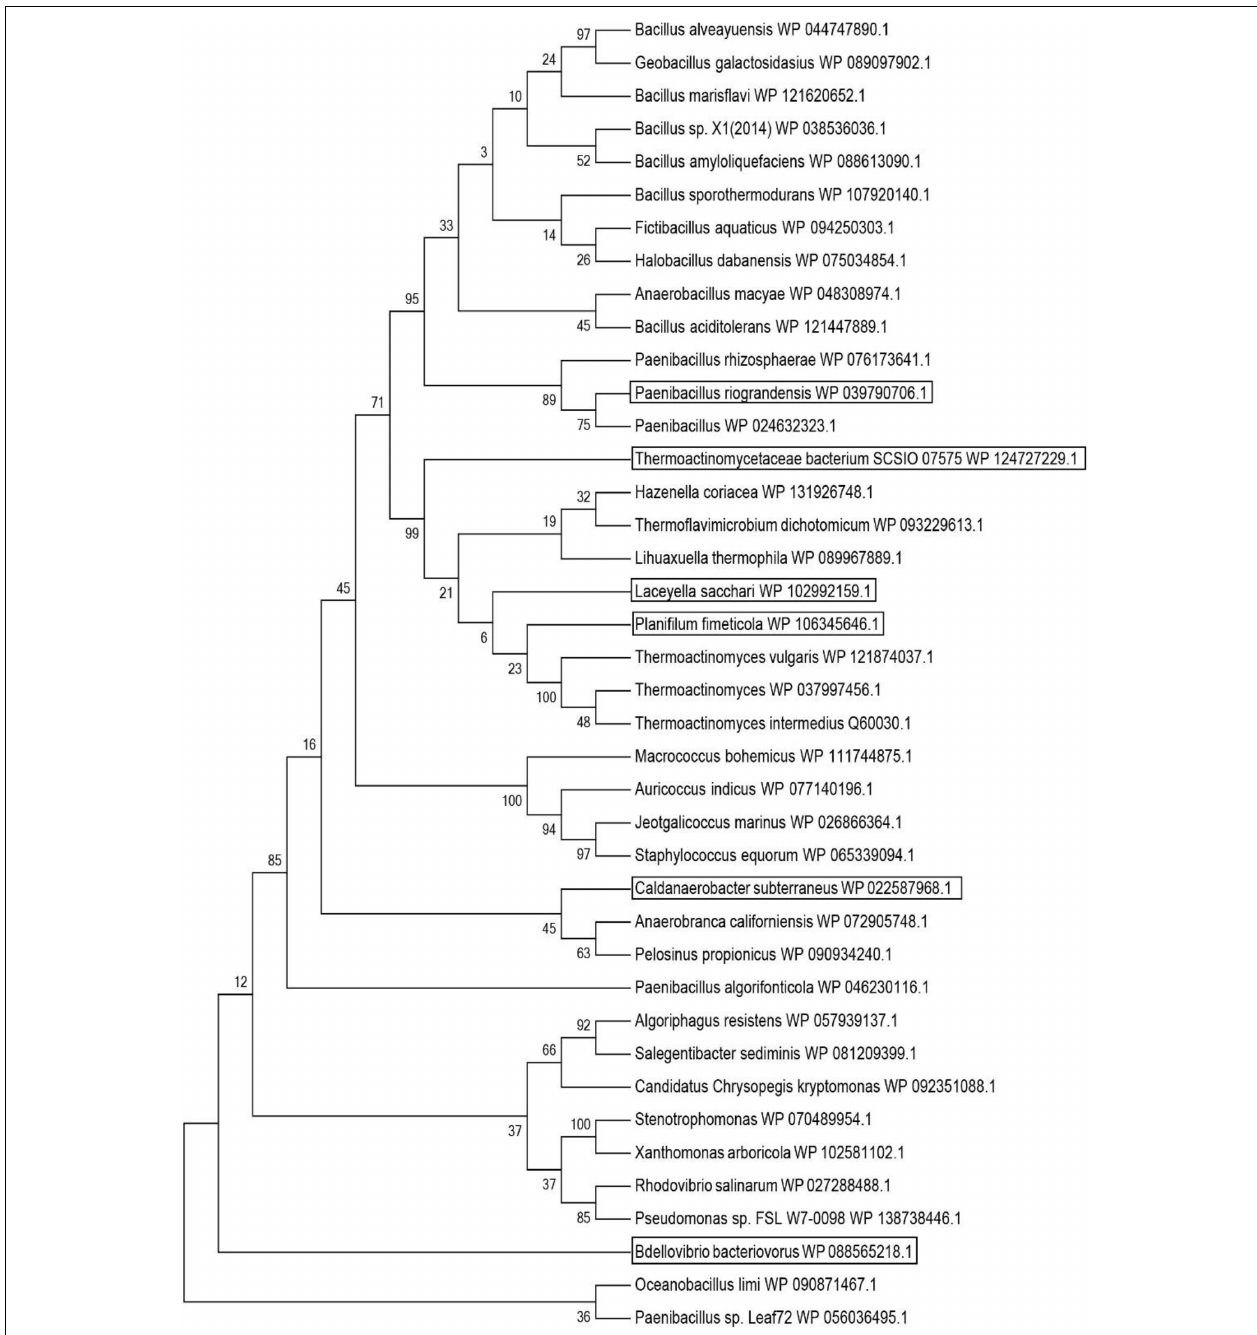
FIGURE 1 | Phylogenetic tree of probe and putative leucine dehydrogenase. The tree was constructed using the MEGA 6 program with the Maximum Likelihood method.